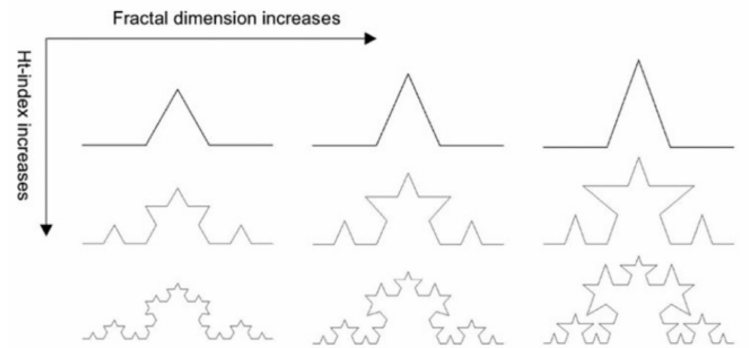
Figure 4. HT index and fractal dimension characterizing the cubic iterative Koch curve (Reprinted from Figure 8 of reference [48]. Ht-Index for Quantifying the Fractal or Scaling Structure of Geographic Features, Bin Jiang and Junjun Yin, Annals of the Association of American Geographers, copyright © 2014 The Association of American Geographers, reprinted by permission of Taylor & Francis Ltd. (Abingdon, UK), http://www.tandfonline.com (accessed on 6 April 2022) on behalf of The Association of American Geographers, www.aag.org (accessed on 6 April